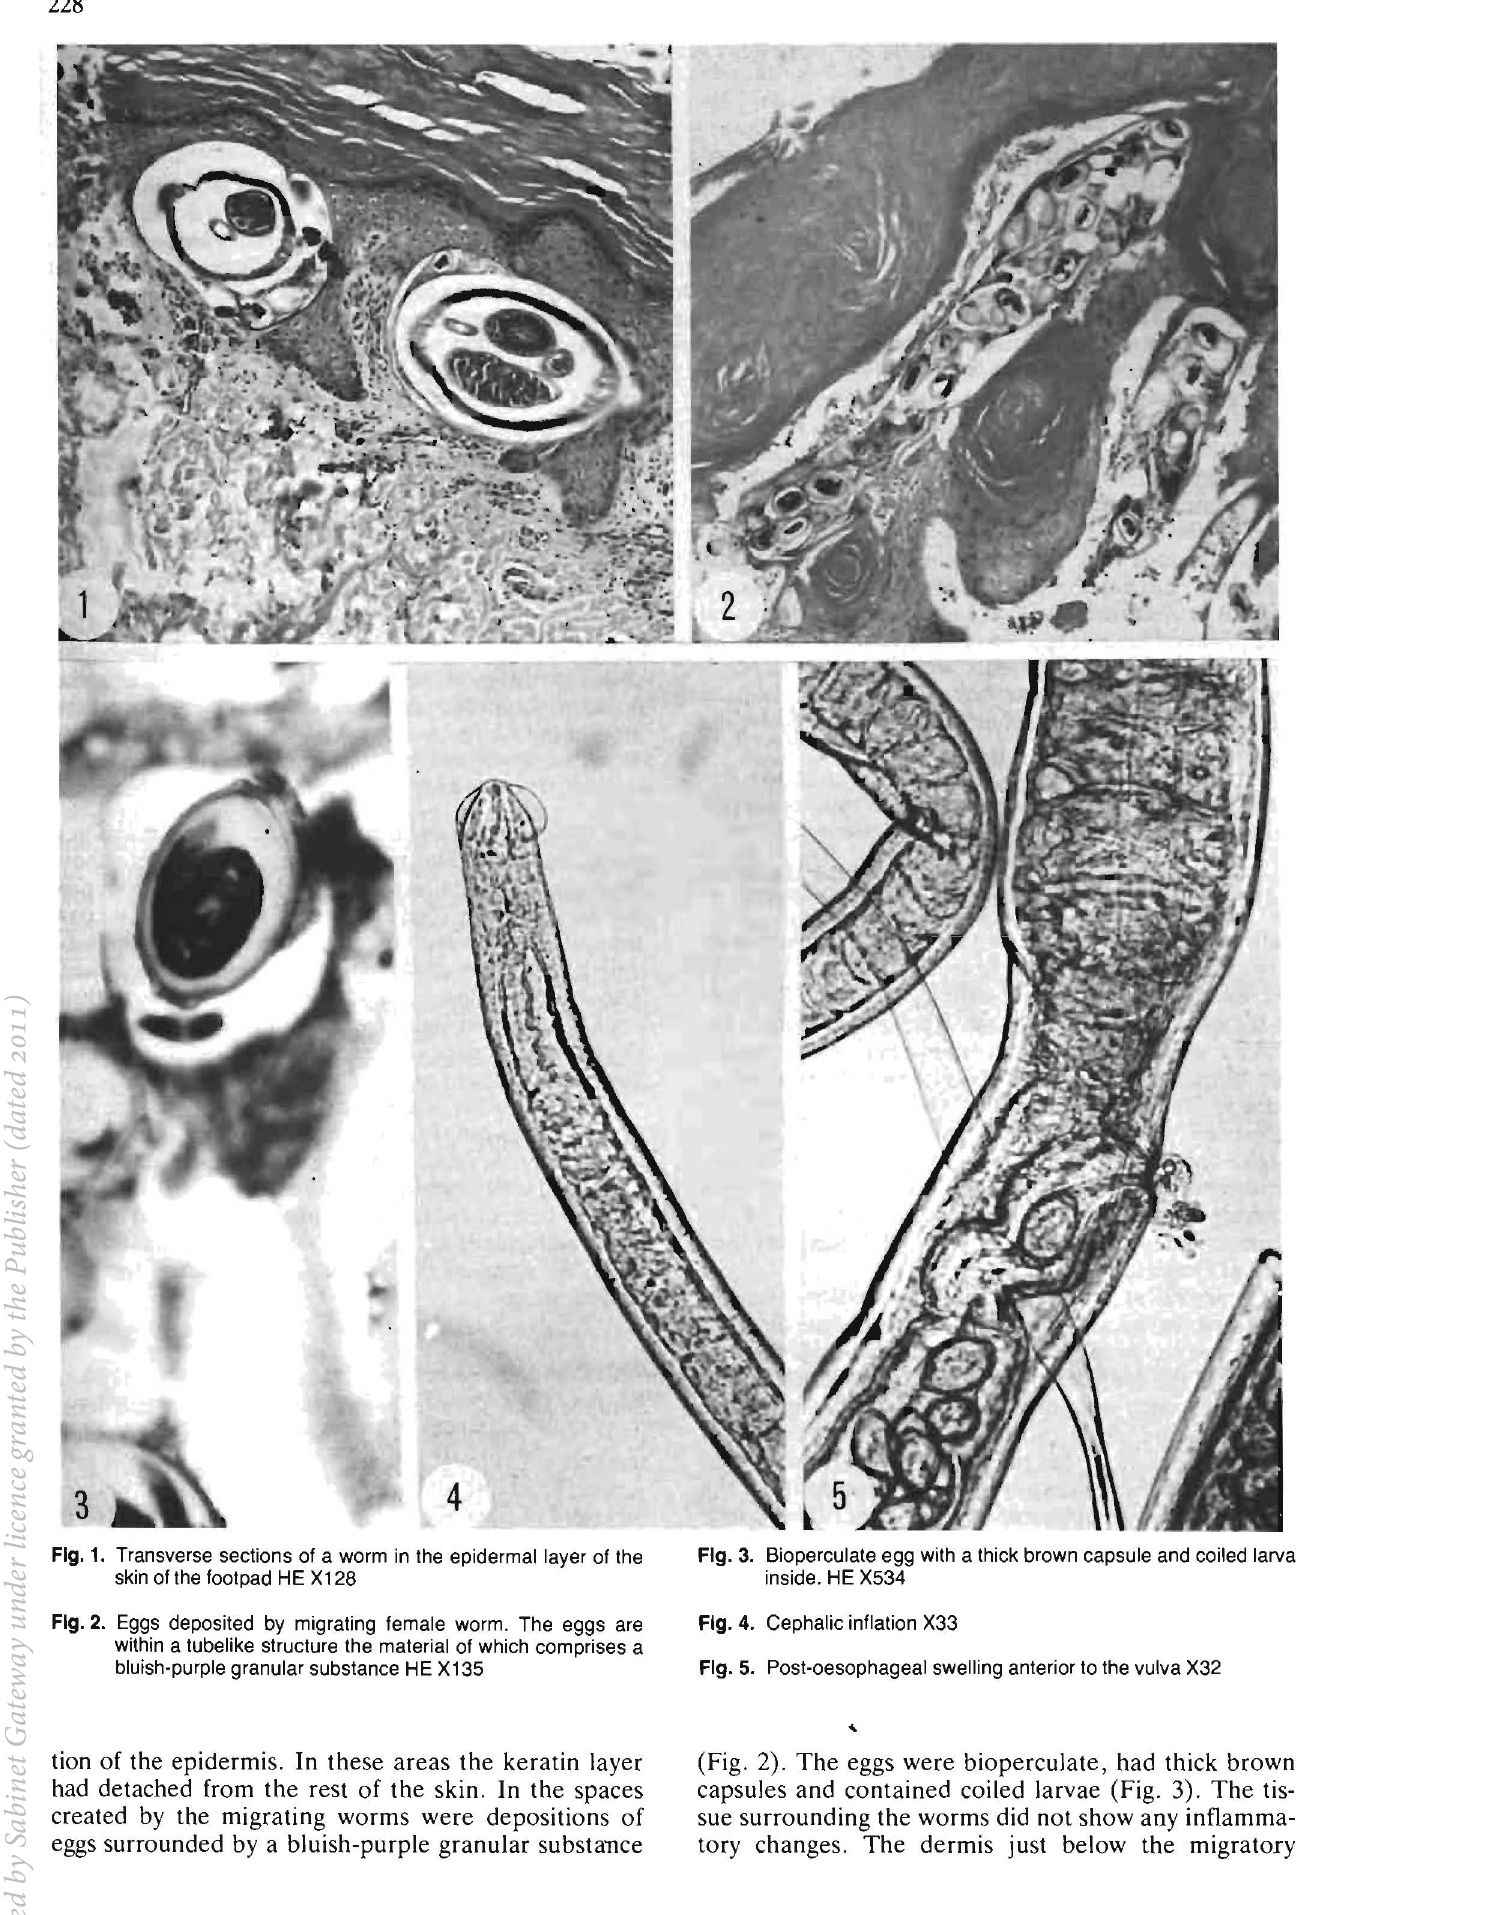
(Fig. 2). The eggs were bioperculate, had thick brown capsules and contained coiled larvae (Fig. 3). The tis sue surrounding the worms did not show any inflamma tory changes. The dermis just below the